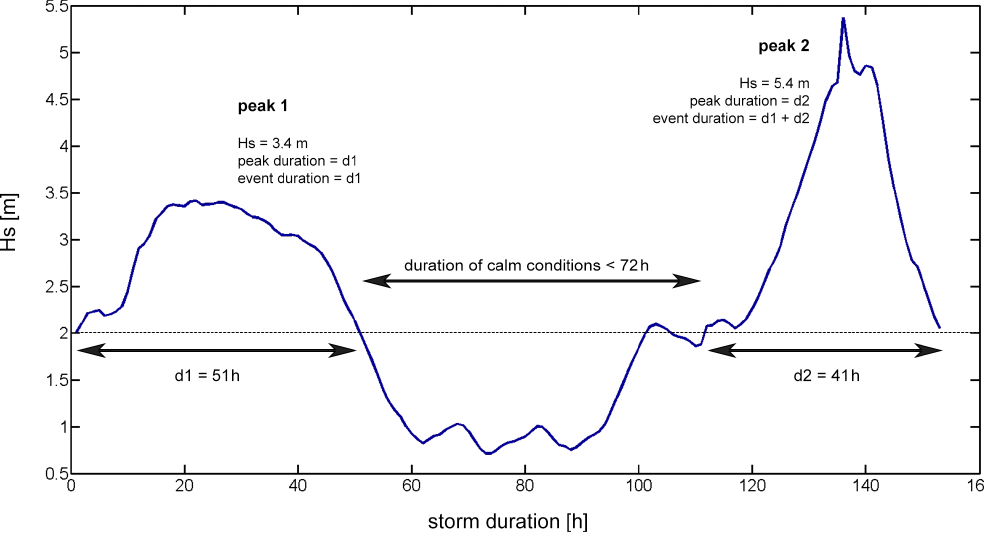
Figure 2. Scheme of a double-peak storm.